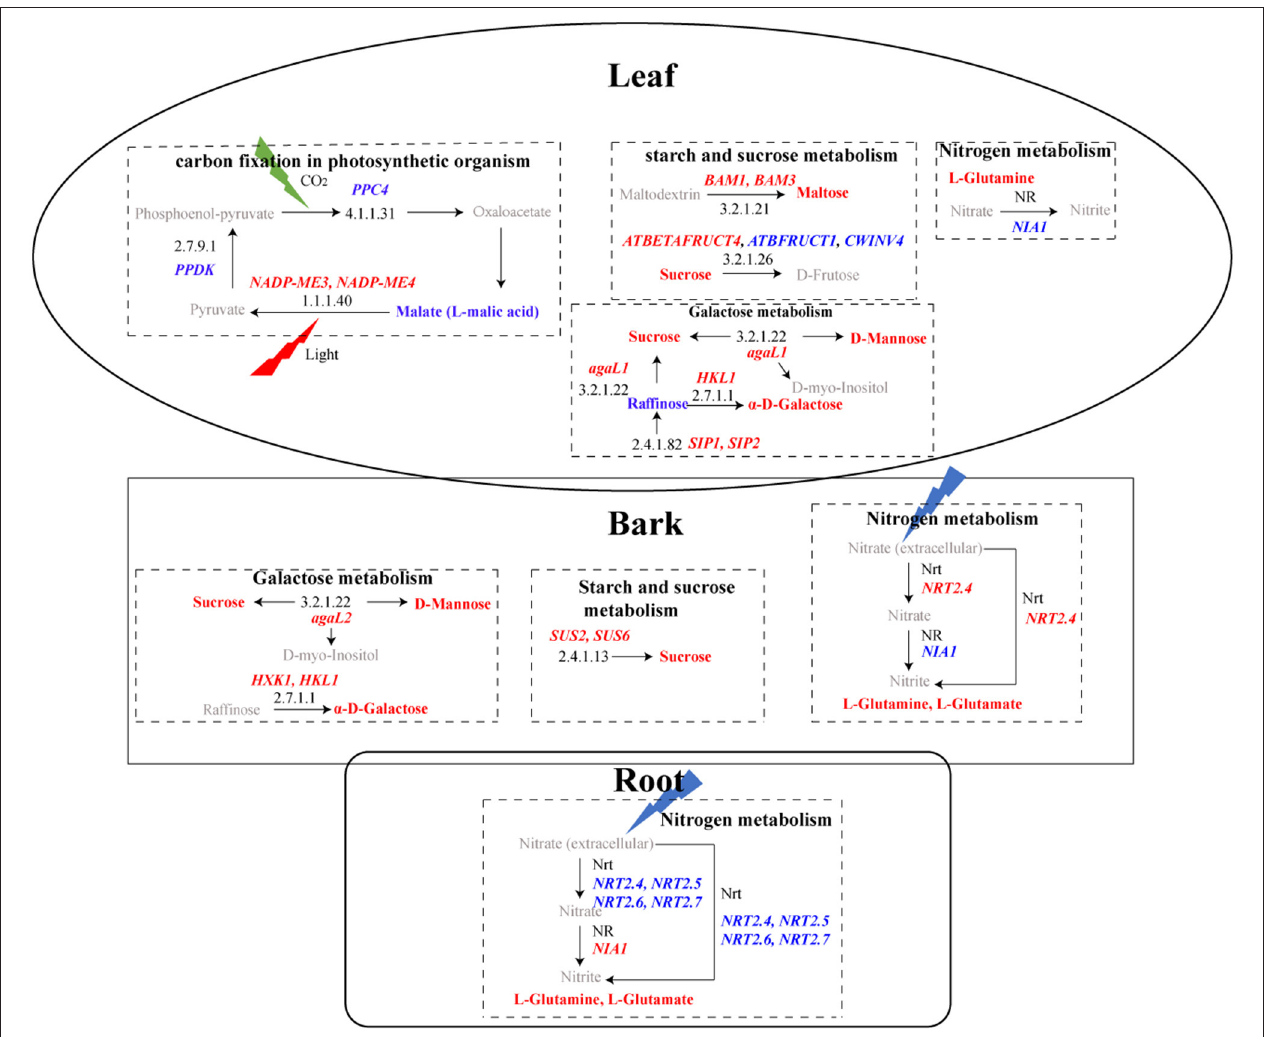
FIGURE 7 | KEGG pathways with DEGs and DAMs in leaves, bark, and roots. In the rectangular box, pathways are represented in bold black, and black numbers represent the KEGG ID of enzymes. Upregulated genes are in red bold italicized words, while downregulated genes are in blue bold italicized words. The red bold represents upregulated metabolites, while the blue bold represents downregulated metabolites. Gray represents metabolites that were not